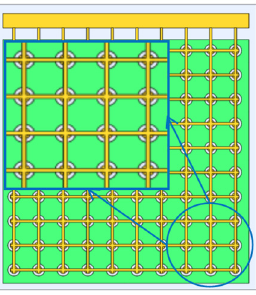
Figure 2. Schematic view of capacitive micromachined ultrasonic transducer array element.